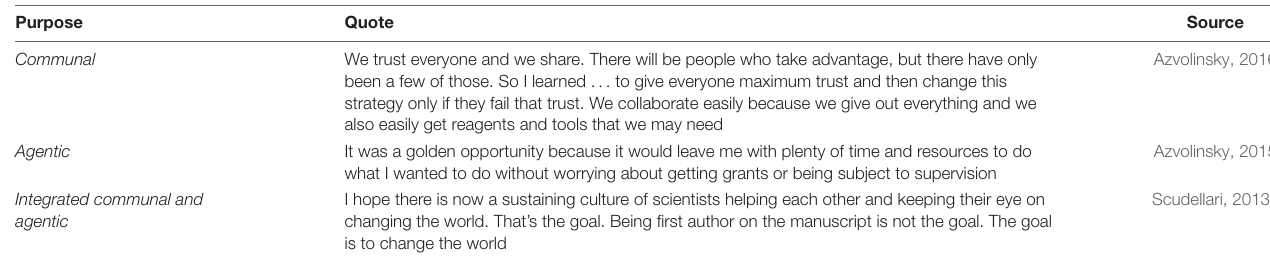
TABLE 2 | Selected examples of communal and agentic purpose. Purpose Quote Source Communal